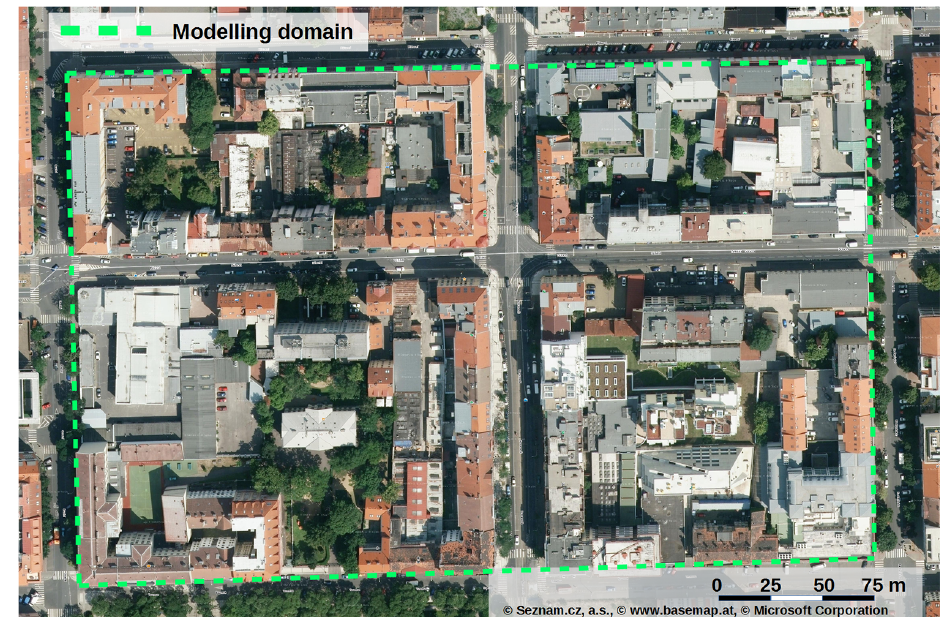
Figure 2. Aerial photo of the studied area.